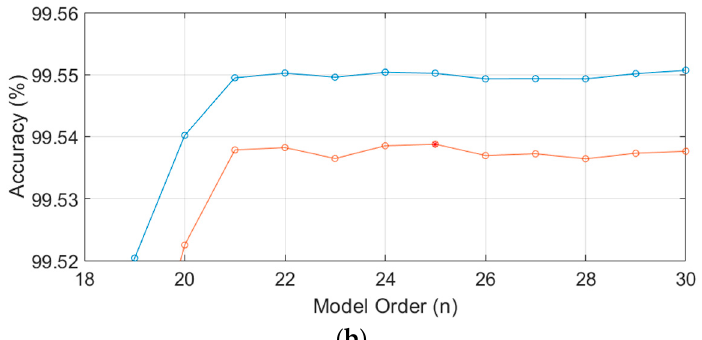
Figure 15. Model order determination via 2-fold cross validation: ( a ) The training and validation accuracies by MNRMSE at different model orders, wherein the best model order of 25 is indicated by an asterisk; ( b ) Zoom-in to the range near order 25.